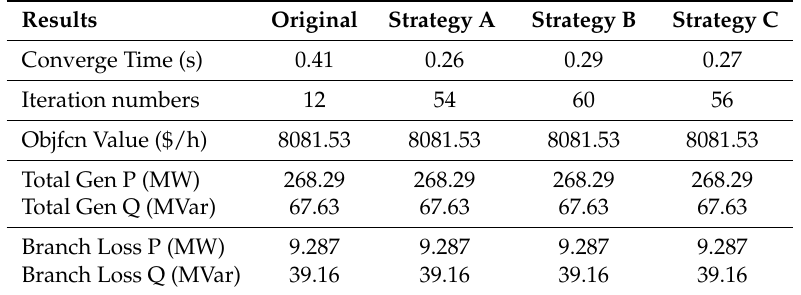
Figure 12. Comparions in the convergence time. Baseline (blue bar) is using original MIPS solver. Strategy A (red bar) is using only regionalization strategy A until convergence. Strategy A+B (yellow bar) is the combination of regionalization strategies A and B, Strategy A+C (purple bar) is the combination of regionalization strategies A and C. Table 2. Single strategy time cost and optimization